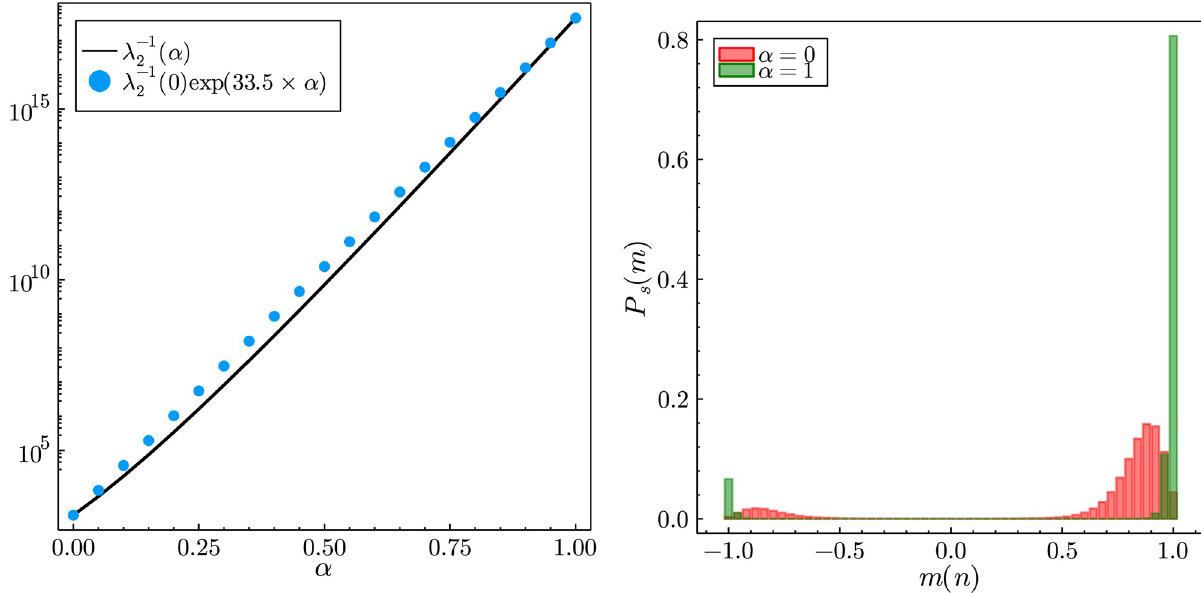
Fig 6. For the set of parameters explored in Fig 3 we explore how the metastable relaxation times (using our very accurate approximation) and the equilibrium distribution behave with respect to changing agent altruism. The left-hand plot shows that as agent altruism increases the metastable waiting times (black line) become exponentially large in α . The blue dots show an exponential approximation to l (cid:0) 1 exponential behaviour. The right-hand plot shows the change in the equilibrium ( t ! 1 ) distributions. For increasing agent altruism populations become more polarised in each behavioural mode (with much reduced fluctuations) even in the metastable